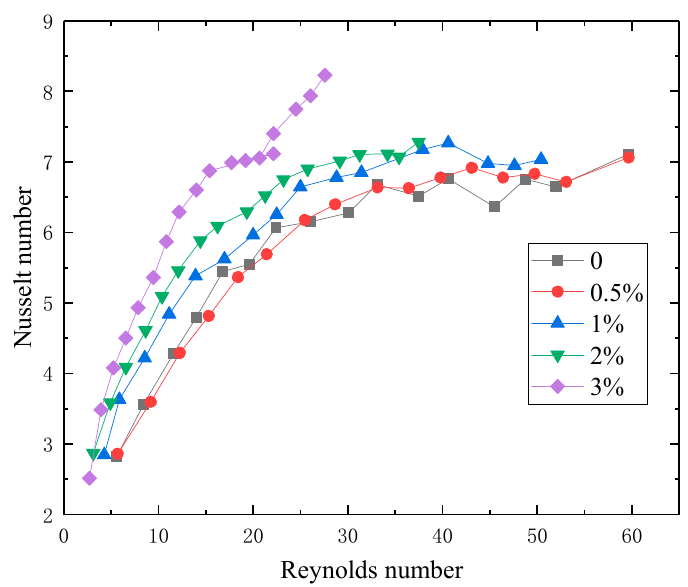
Figure 13. Nusselt number of prepared nanofluid samples at different Reynolds numbers.